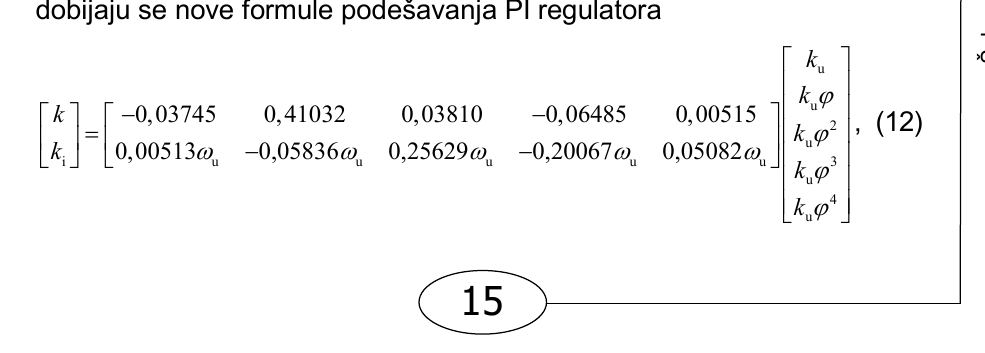
Figure 8 – Parameters of the normalized PI controller, obtained by applying the normalized model (9) and the max(J c ) method for M s =2 and ρ